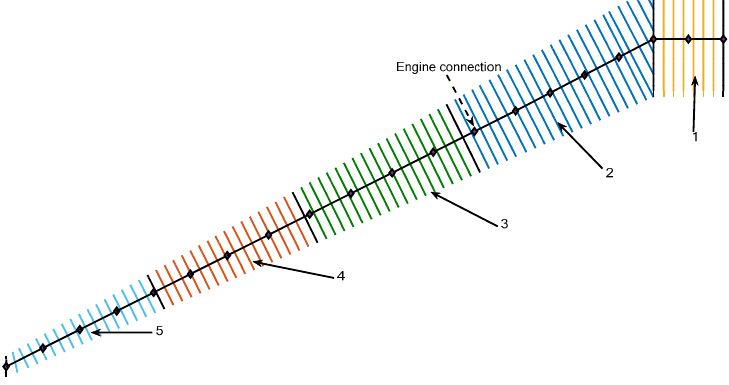
Figure 4. Example of patches subdivision.